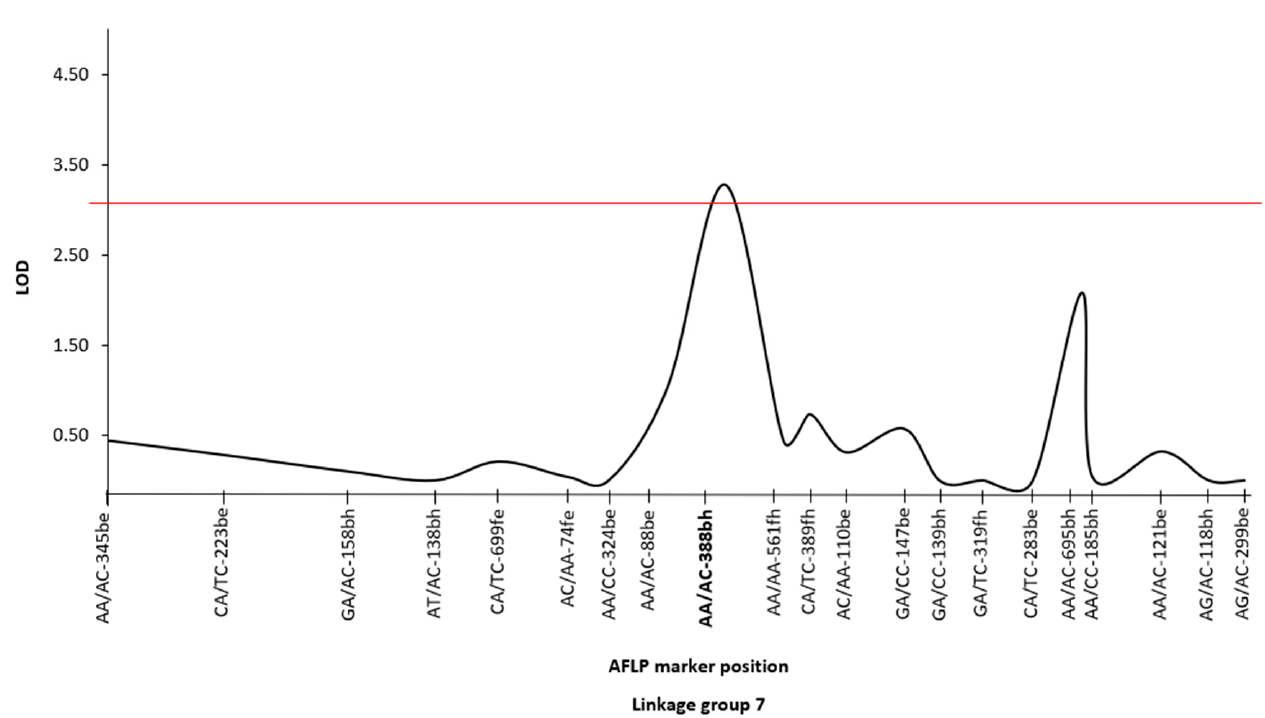
6 of 17 Figure 1 . Mycelial growth differences between F. circinatum FSP34 ( red ), F. temperatum ( blue ), and the F 1 progeny were observed after 7-day growth on PMEA (pine-tissue extract containing malt extract agar) growth medium. The error bars represent the standard deviation. Quantitative trait analysis using the recorded growth measurements and the GLM data produced by De Vos et al. [26] allowed for the detection of one significant ( p < 0.05)